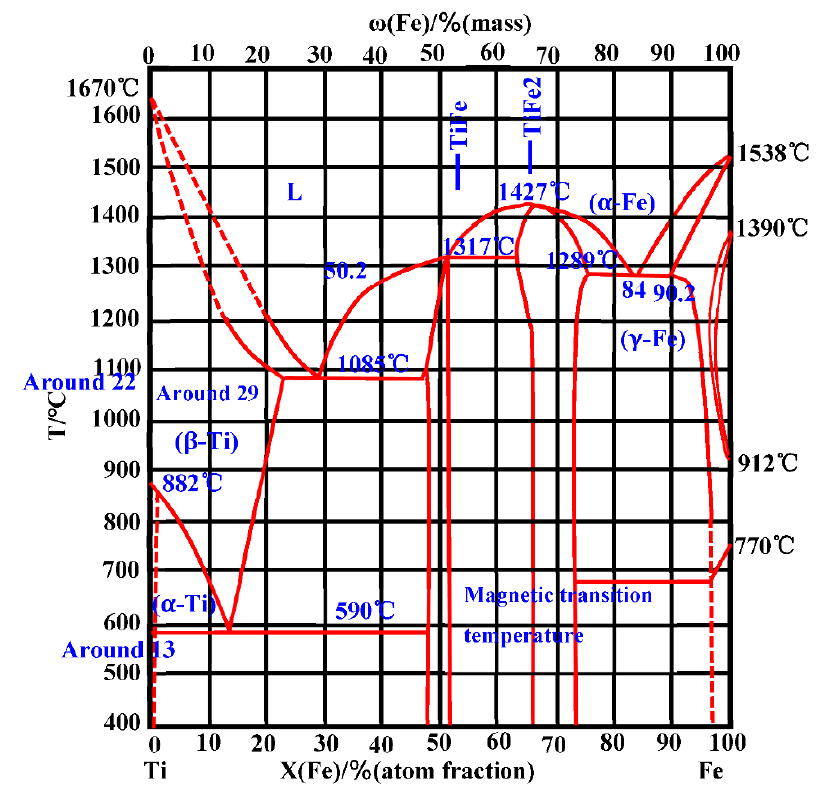
Figure 2. Ti-Fe binary phase diagram